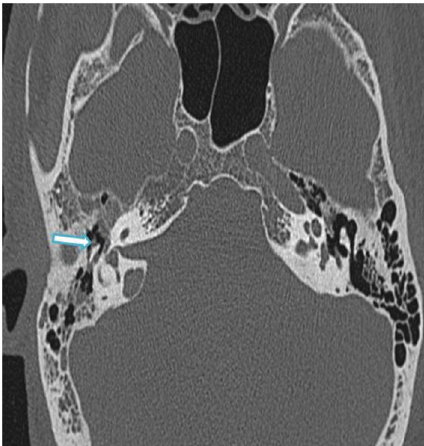
Fig. 11 Axial HRCT temporal bone image of a 66-year-old male patient with complaints of otalgia and reduced hearing showing soft tissue attenuation in right middle ear and mastoid air cells with ossicular erosion of head of malleus (arrow)—invasive